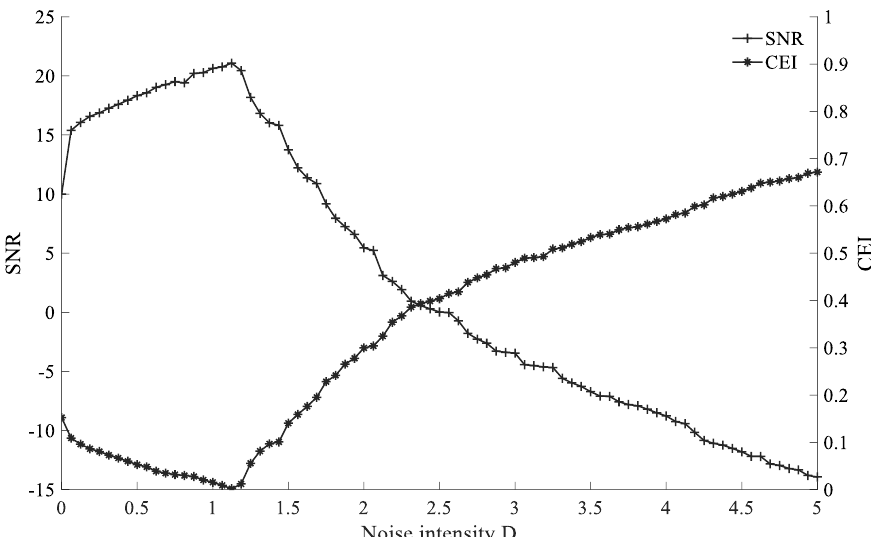
Figure 8. Comparison between SNR and CEI of the SR system.